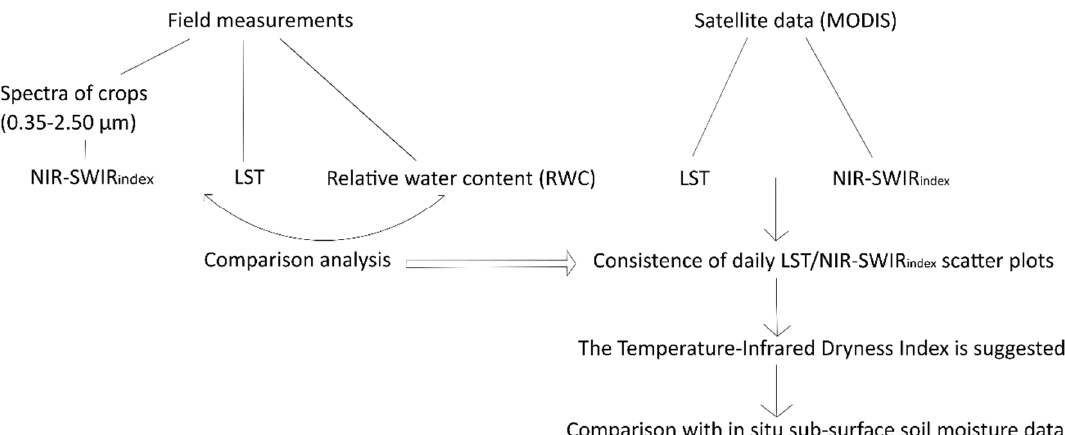
Figure 4. Flowchart of the applied method using in situ and satellite data.